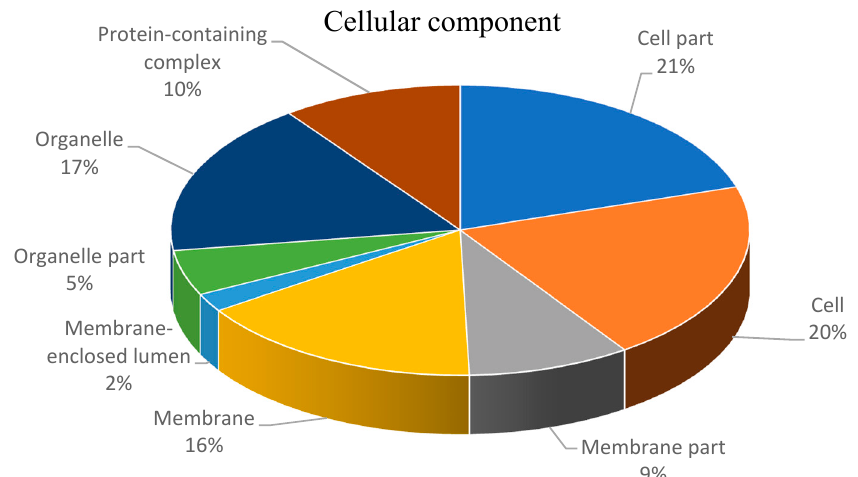
Figure 2. Functional classification analysis of increased abundance proteins according to their molecular function ( A ), biological process ( B ), and cellular component ( C ). Decreased abundance proteins were involved in the molecular function such as binding (fourteen proteins), catalytic activity (nine proteins), molecular function regulator (one protein), structural molecular activity (three proteins), and translation regulator activity (one protein) (Figure 3A). Proteins associated with biological process involved biological regulation (seven proteins), biogenesis (seven proteins), cellular process (twelve proteins), developmental process (three proteins), localization (one protein), metabolic process (two proteins), response to stimulus (five proteins), and signaling (three proteins) (Figure 3B). These proteins were classified into cellular components such as cell and cell part (fifteen proteins each), membrane (two proteins), organelle and organelle part (nine and six proteins each), protein-containing complex (six proteins), and supramolecule complex (one protein) as shown in Figure 3C.